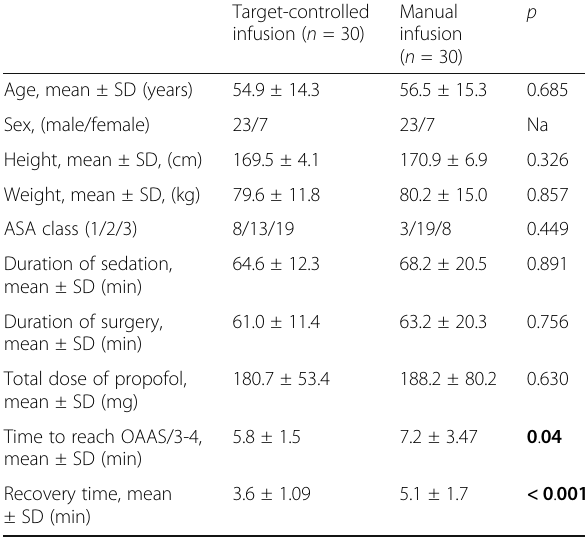
Table 3 Clinical and procedural characteristics of the